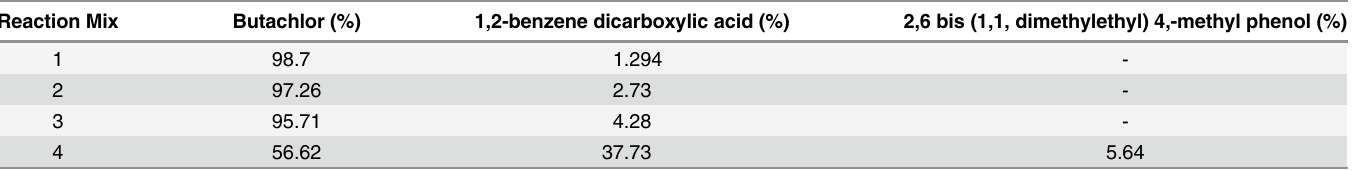
Table 2. Percent composition of butachlor and metabolites as determined by GC-MS analysis. The GC-MS measurements were carried out with the metabolites extracted from the reaction mix containing 50mM potassium phosphate buffer pH 7.4, 0.4 mM butachlor and 10mM 2-mercaptoethanol, (1) nei- ther NADPH nor AKR, (2) NADPH (0.12mM), (3) AKR (5 μ g), or (4) both NADPH (0.12mM) and AKR (5 μ g). Reaction Mix Butachlor